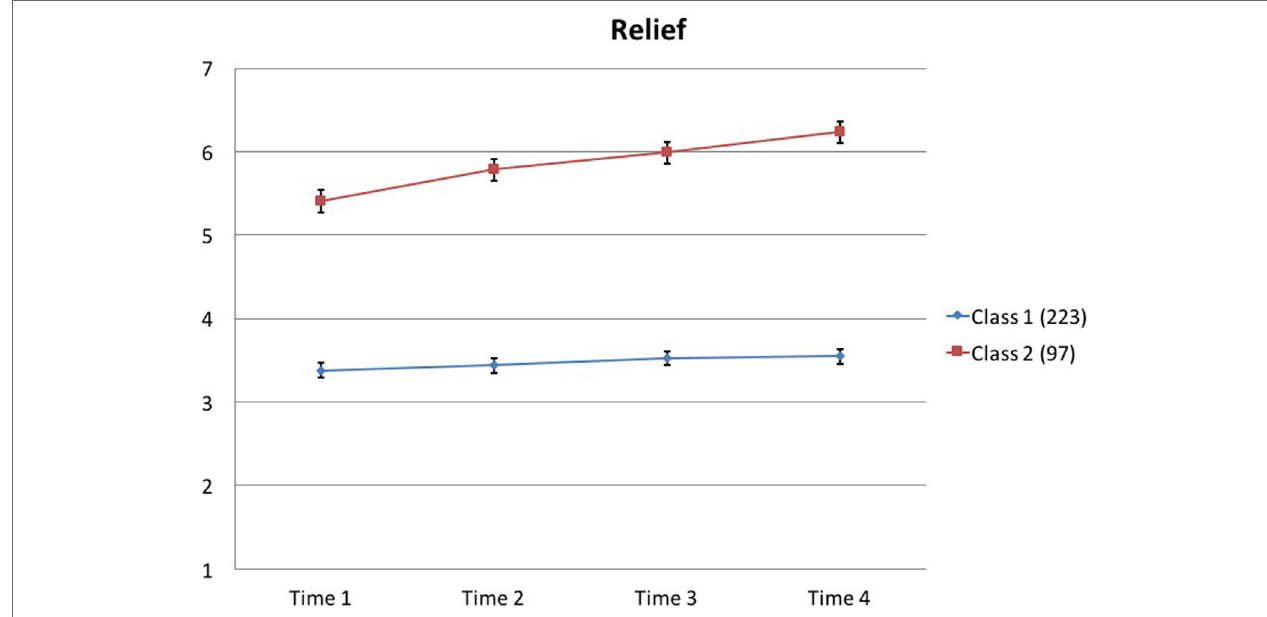
FigUre 4 | Latent profiles of